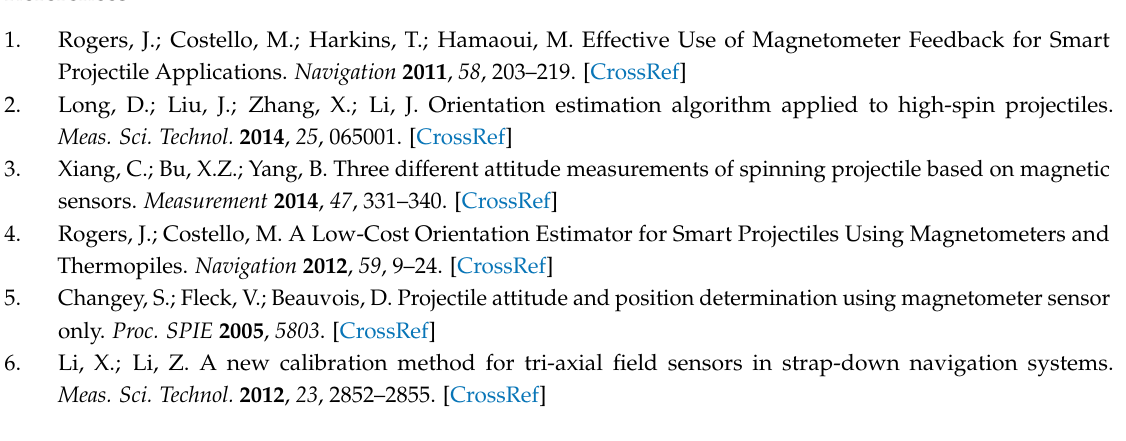
Figure 25. Pitch angle error versus time. Figure 26. Roll angle error versus time. Figure 26. Roll angle error versus